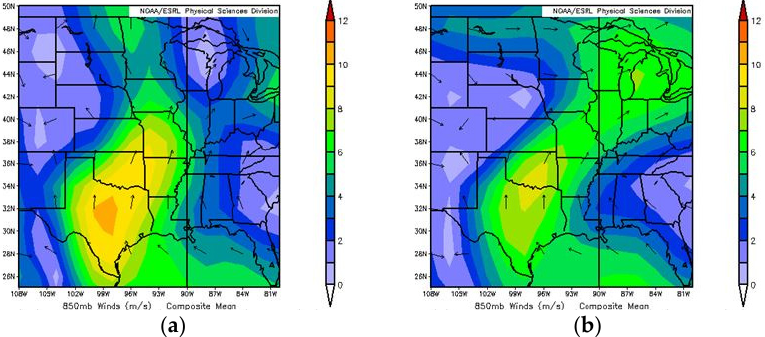
Figure 6. The 850-hPa isotach wind (shaded; every m·s − 1 ) from 0 to 12: ( a ) composites for elevated convection; and ( b ) composites for surface based convection.